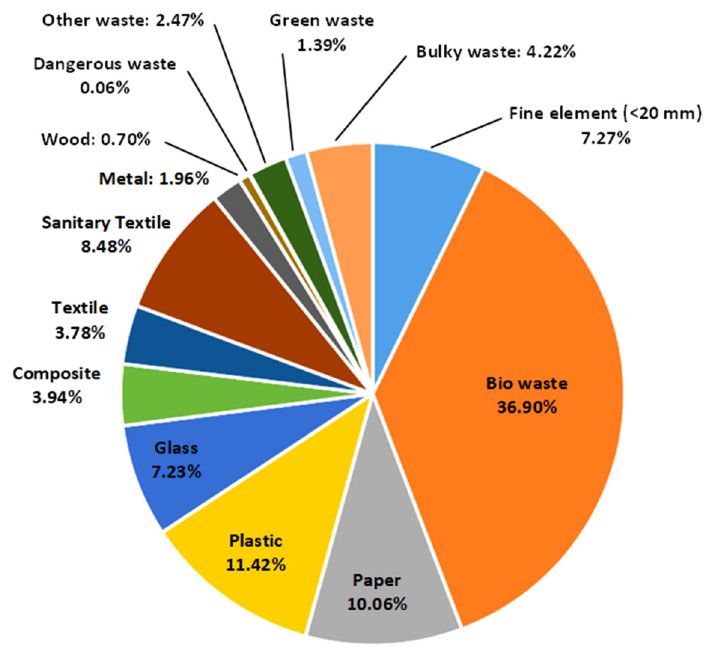
Figure 6. Physical characterization of municipal solid waste in the year 2020 (%) [43].